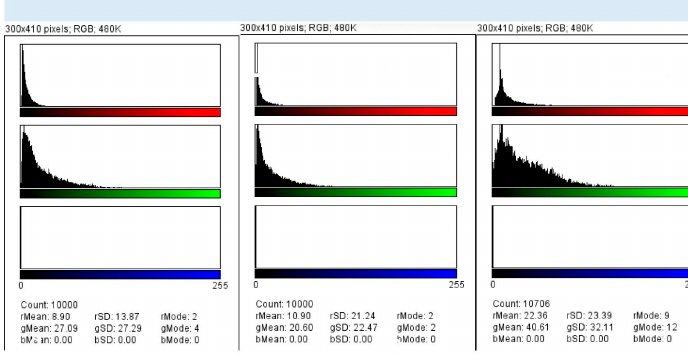
Figure 9. The upper panel shows the rationale of using JC-1 to determine the depolarization/disruption of the mitochondrial membrane, with the three-color histograms of red, green, and blue fluorescence representing 0 TQ, DMSO, and 50 µM TQ for HepG2 cells, and the